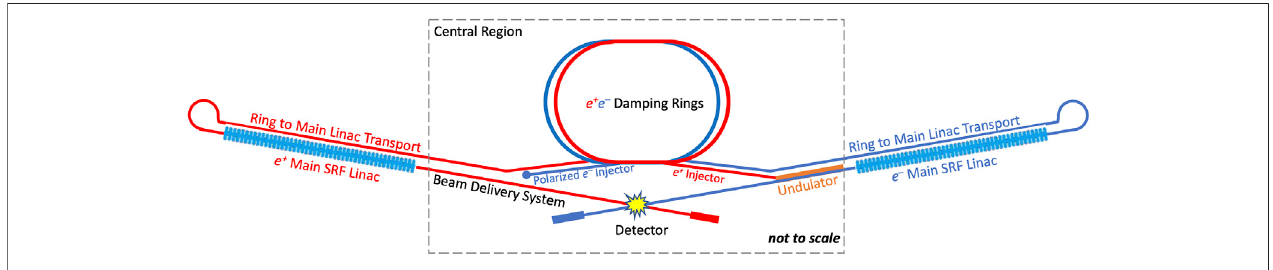
FIGURE 1 | Layout of a “ generic ” SRF linear